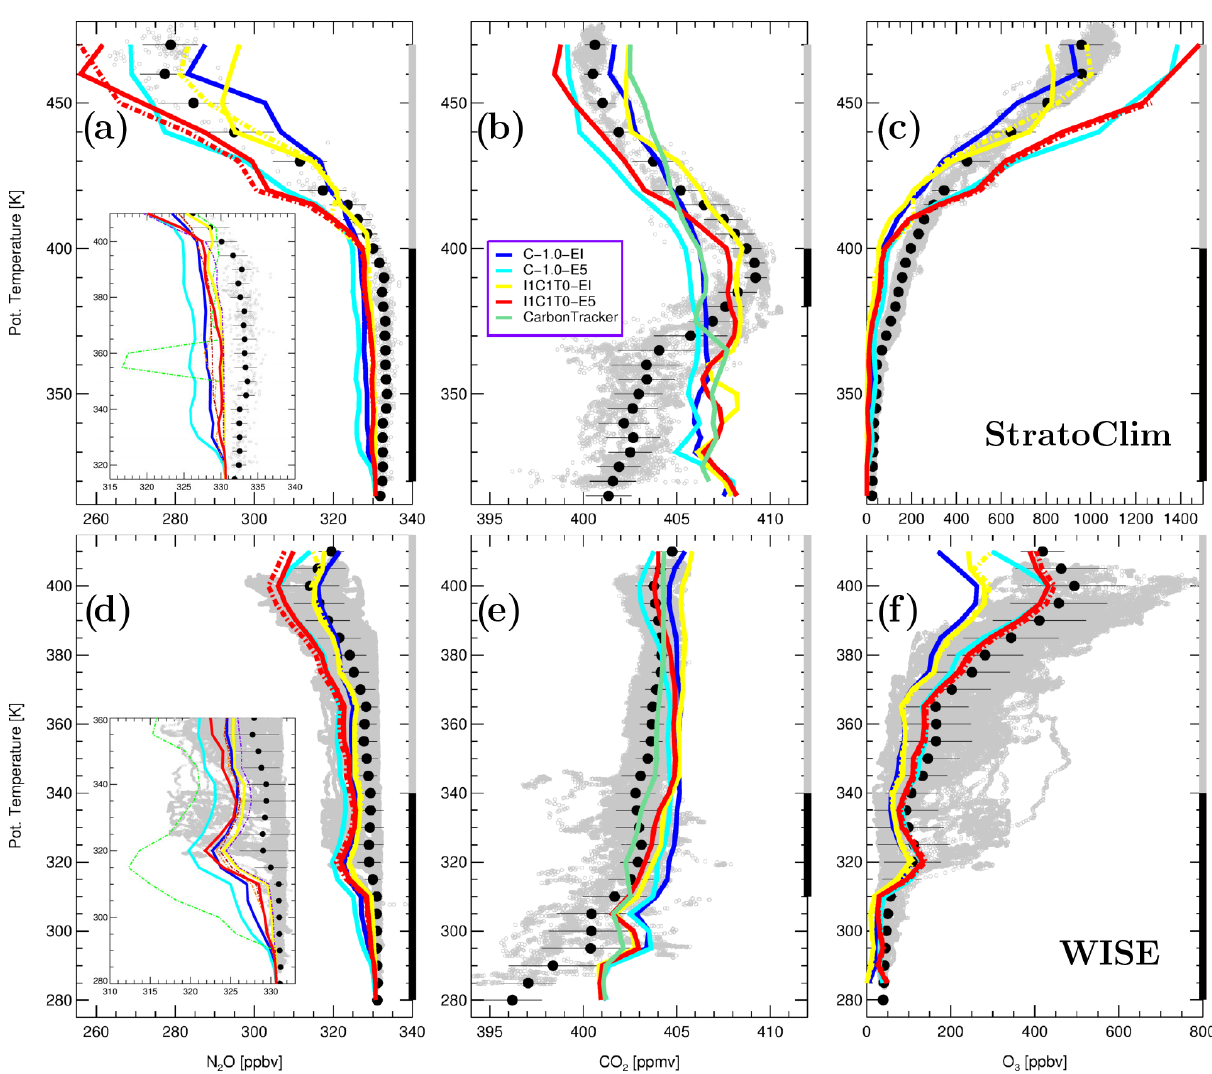
Figure 5. Same as in Fig. 4 but for N 2 O (a, d) , CO 2 (b, e) , and O 3 (c, f) observations versus CLaMS for the most important model config- urations listed in the legend of Fig. 4. For the baseline runs (C-1.0) and for the best runs (I1C1T0), thick solid lines are used. Dashed thick lines denote results of the respective perpetuum runs. Top and bottom panels show the StratoClim- and WISE-related profiles, respectively. CO 2 profiles directly obtained from the CarbonTracker data are also shown (beige green). In the subpanels for N 2 O, details of tropospheric profiles are higher resolved and color-coded as in Fig. 4. Table 4 compares the root mean square differences and Sect. 3.6 discusses the stratospheric performance within the tropospheric and stratospheric ranges,